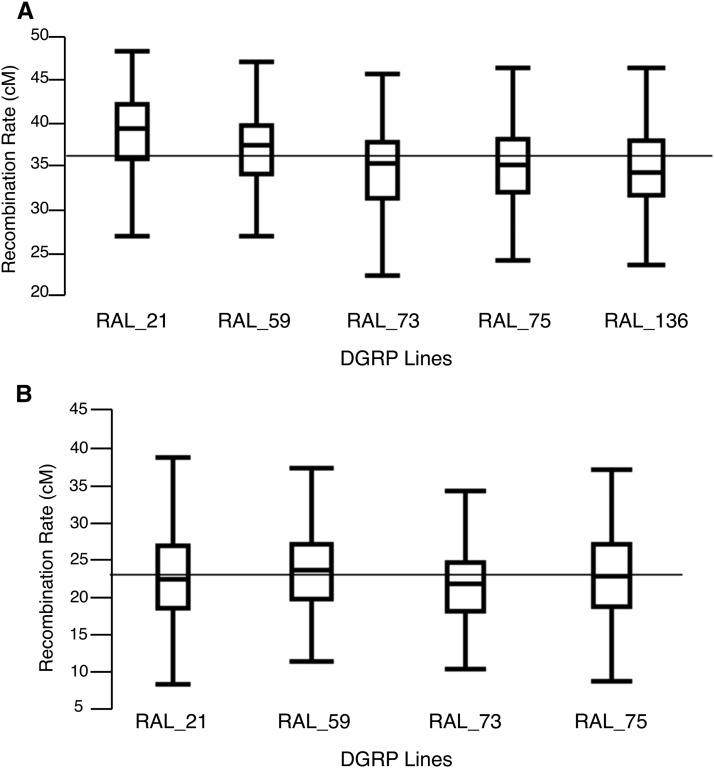
Crossover frequency summed across an individual female’s lifetime for the (A) y v interval or (B) e ro interval. Boxplots show first to third quartiles with median denoted by line inside the box with whiskers extending to the smallest and largest nonoutliers, while the gray line indicates the grand mean.